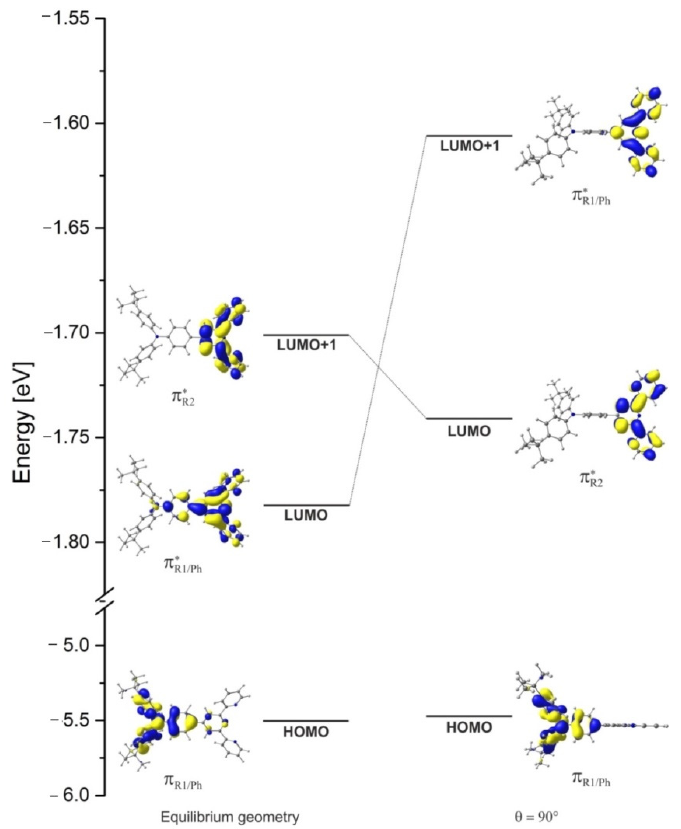
Figure 10. Energy diagram of the HOMO, LUMO and LUMO+1 orbitals for the two extreme dihedral rotational angles of the terpyridine substituent with respect to the central phenyl ring (Equilibrium geometry and 90°).